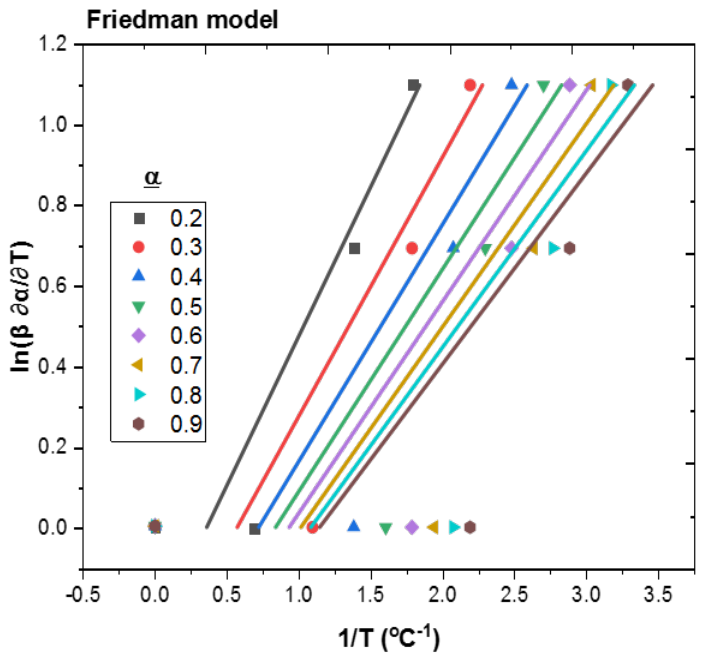
Figure 5. Friedman model plots for the thermal degradation of PET MPs.